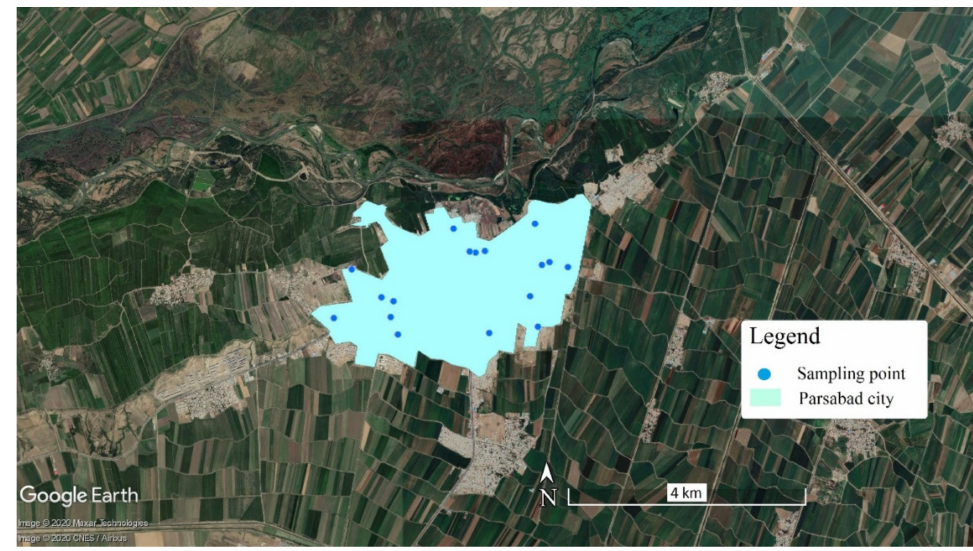
Figure 1. Location of urban drinking water sampling points in the study